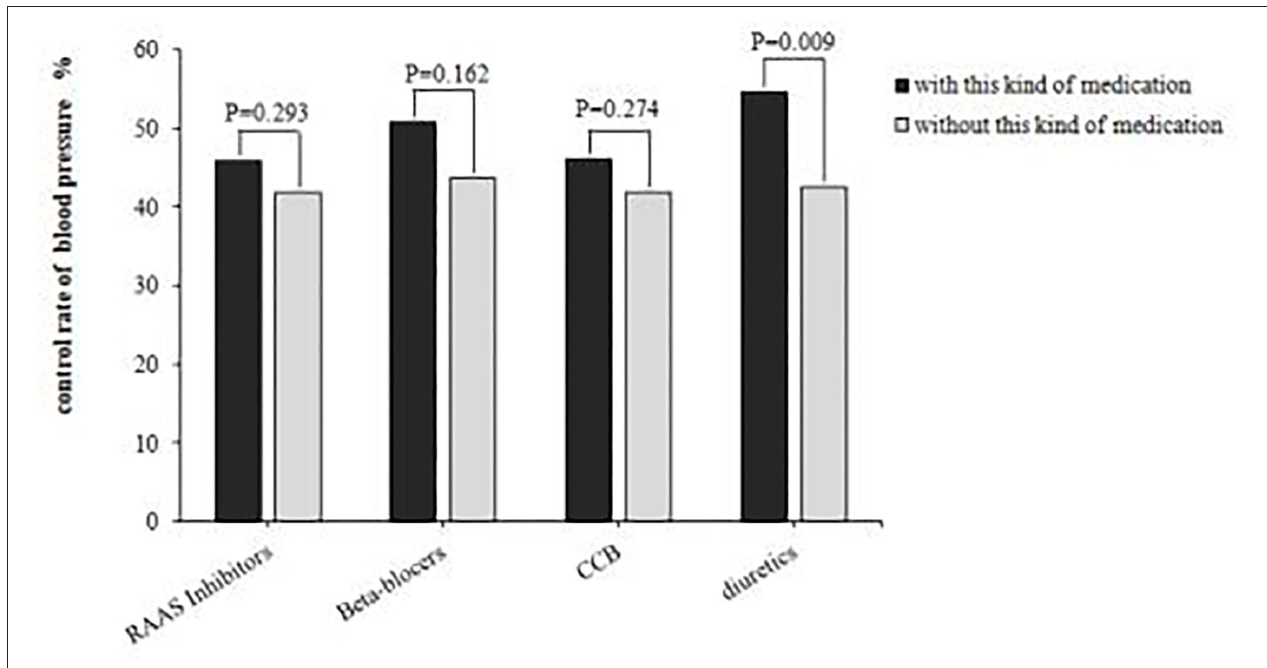
FIGURE 2 | Comparison of blood pressure control rates among different medication. RAAS, renin-angiotensin-aldosterone system; CCB, calcium channel blockers.